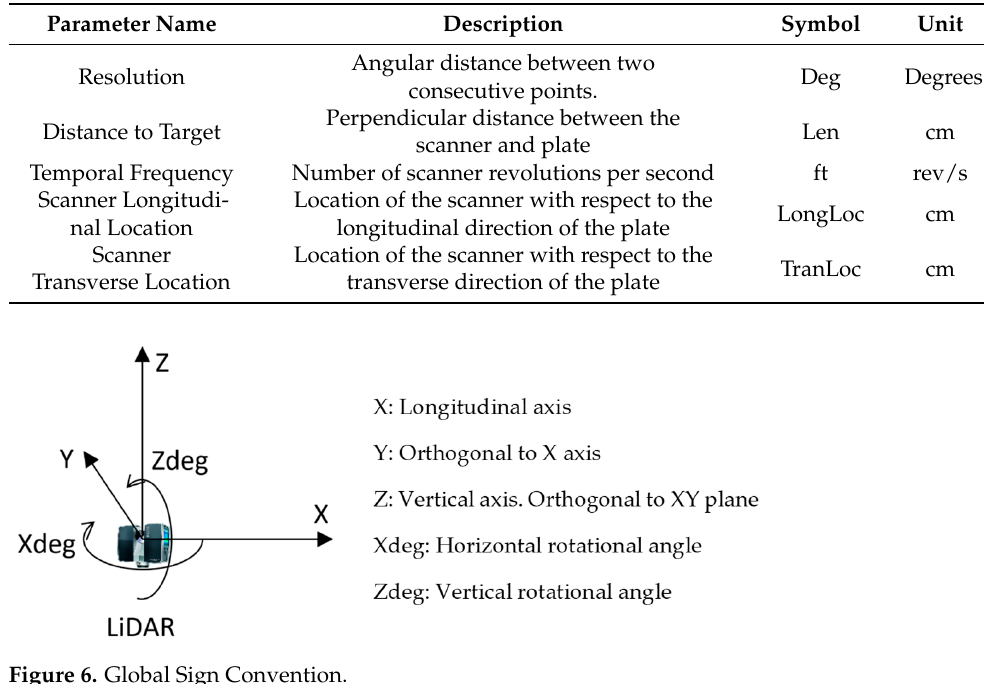
Table 5. Numeral model input parameters. Scanner settings.